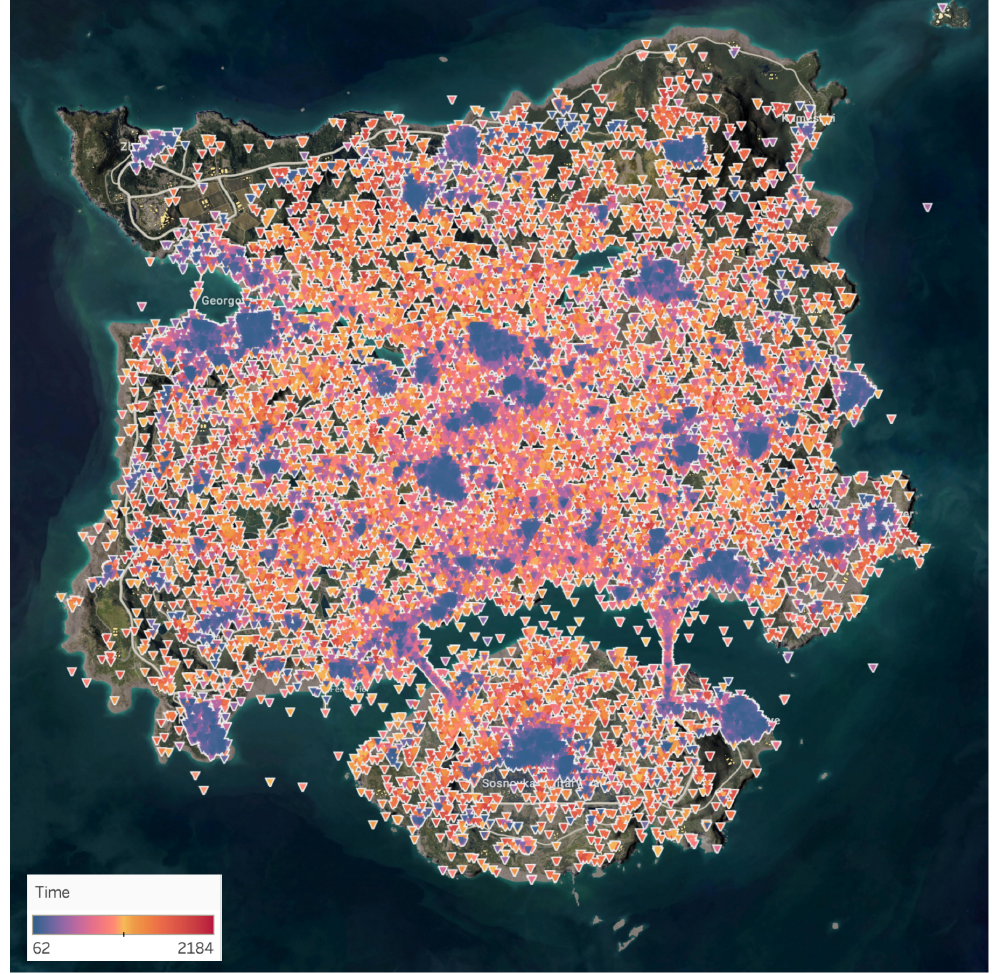
Figure 3. The figure is a visualization of the data clustered by observation for the data placed onto the two-dimensional